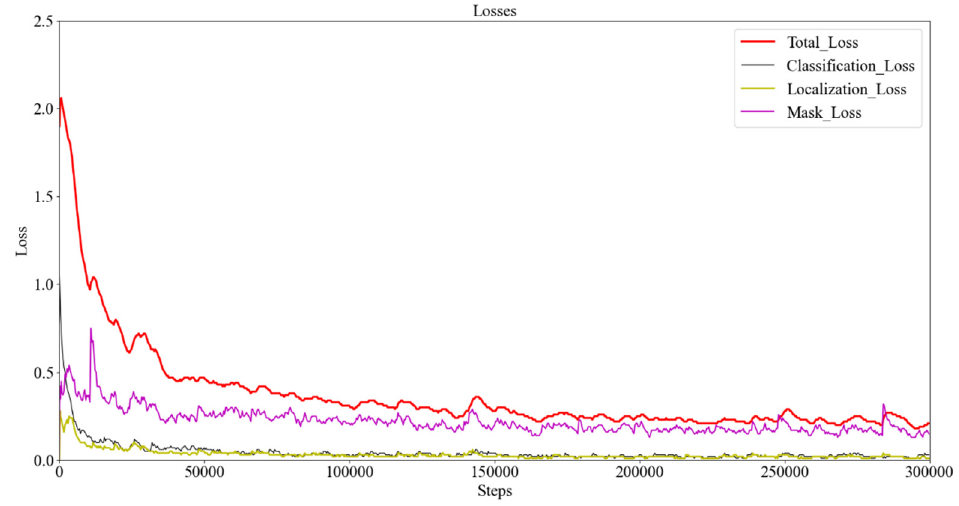
Figure 8. Relationship between loss and steps.